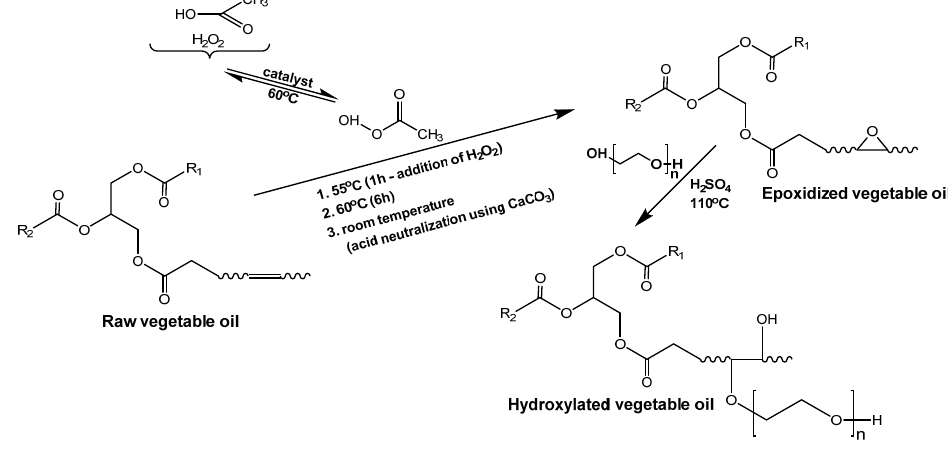
Figure 1. Synthesis of modified vegetable oil.